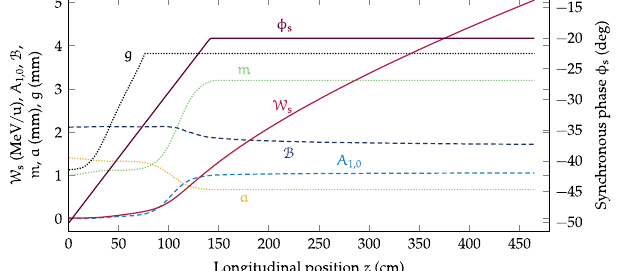
FIG. 12. Beam dynamics parameters of the Carbon-RFQ with trapezoidal vanes.